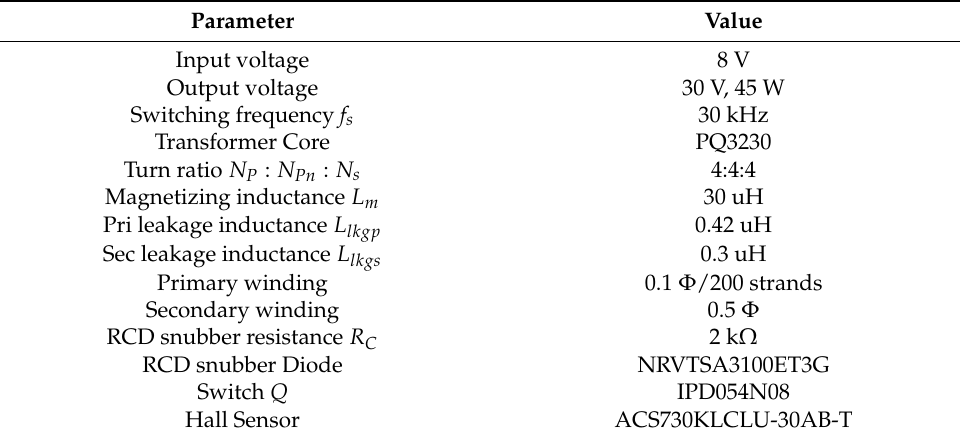
Figure 9. The experimental prototype. Table 3. Proposed DPP converter